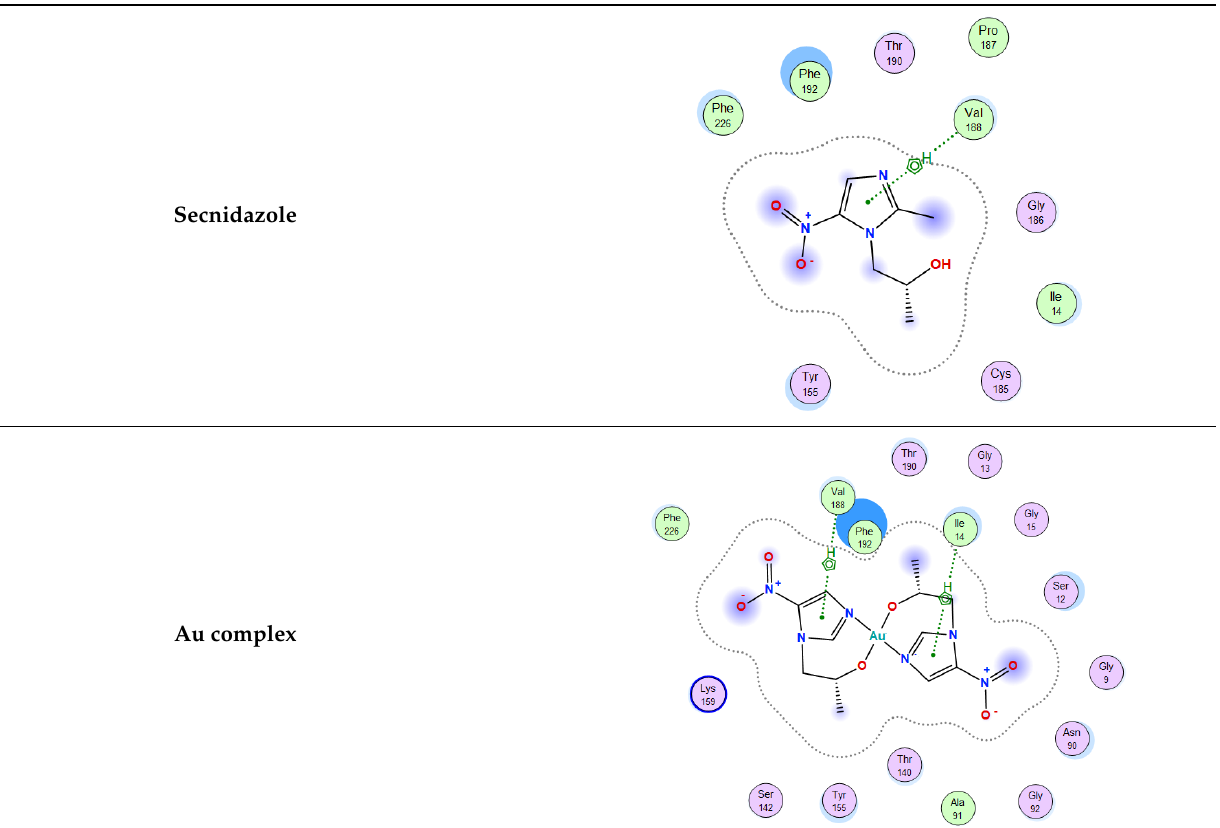
Table 12. 2D and site interaction of the ligand and its metal complexes with 3hb5